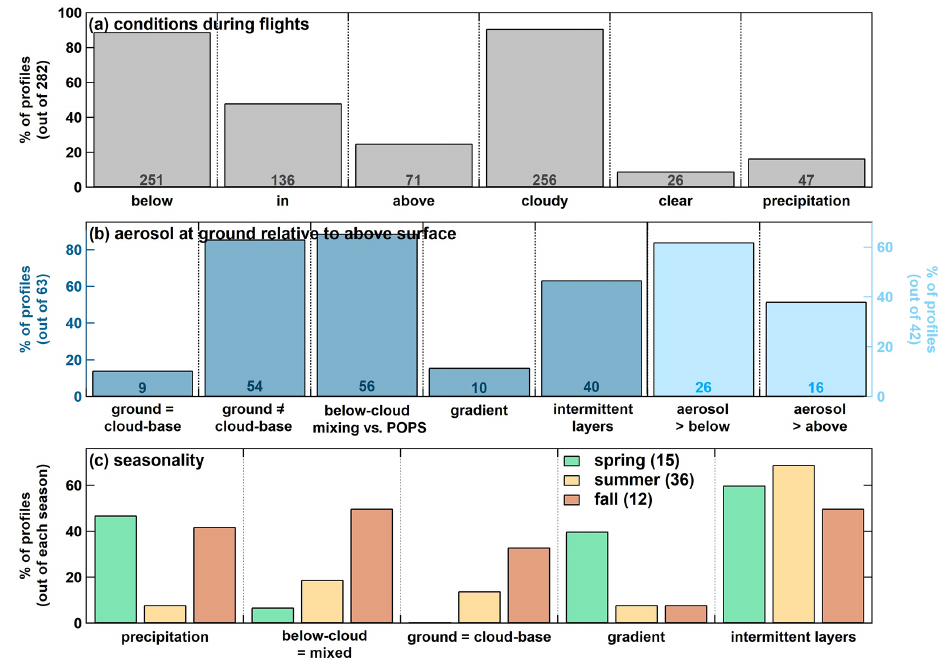
Figure 9. Statistics from all profiles with POPS data (282 total) during the ARM TBS campaigns, including (a) when the POPS flew below, in, and above cloud and conditions during the flights (clear or cloudy), and precipitation. Out of the profiles in which POPS was operational at cloud base and at the ground (63 total), panel (b) shows cases where aerosol concentrations were equivalent or not equal at ground and cloud base. When not equal, cases are categorized into an increasing or decreasing gradient with height when intermittent layers were present, and cases where below-cloud mixing can explain the stratification of the aerosol. Also shown are cases where the POPS measured above and below cloud within the same profiles (42 total) and had higher aerosol concentrations below and above cloud. Panel (c) shows various conditions by season from (b) . The number of cases is provided for (a) and (b) . The number of profiles per season is provided in (c)